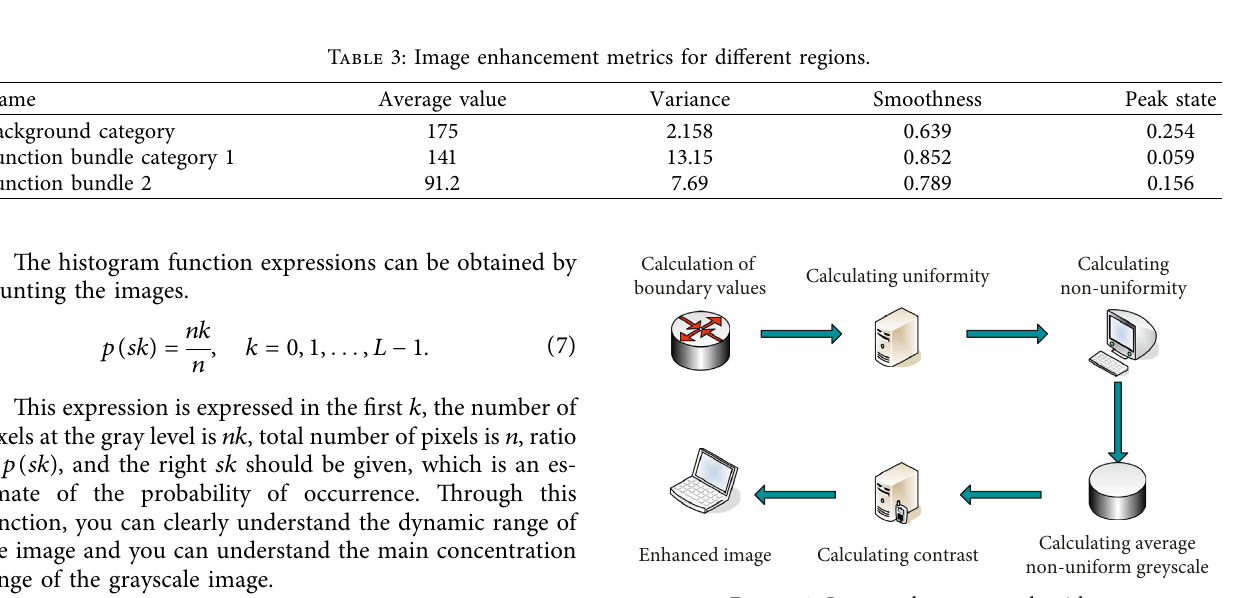
Figure 3: Image enhancement